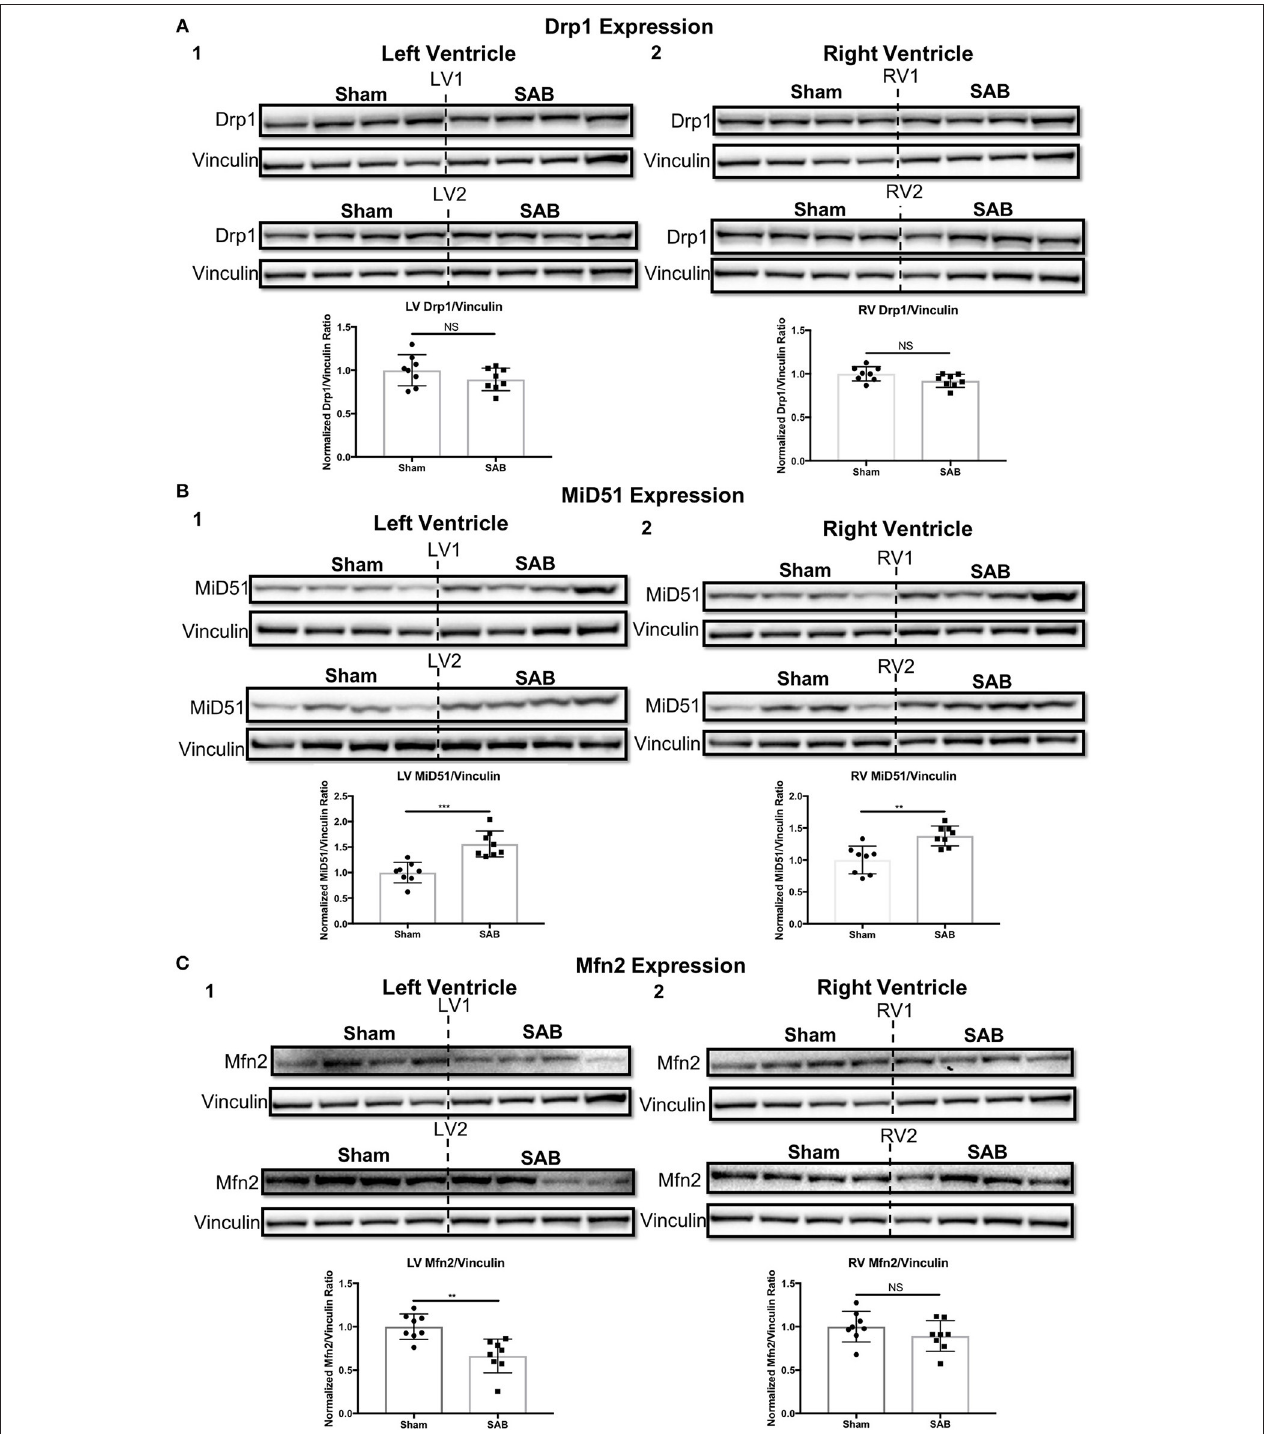
FIGURE 6 | Expression levels of mitochondrial fission/fusion mediators in sham vs. supra-coronary aortic banding (SAB) rats. (A) Western blot showing no change in the expression level of total dynamin-related protein 1 (Drp1) in the (1) left ventricle (LV) and (2) right ventricle (RV) of supra-coronary aortic banding (SAB) rats vs. sham rats. (B) Western blot showing significant upregulation of mitochondrial dynamics of 51 kDa protein (MiD51) in the (1) LV and (2) RV of supra-coronary aortic banding (SAB) rats vs. sham rats. (C) Western blot showing significant downregulation of mitofusin-2 (Mfn2) in the (1) LV and (2) RV of supra-coronary aortic banding (SAB) rats vs. sham rats. Each band represents a unique animal. Two experimental cohorts were done; hence two groups are shown, labeled as 1 and 2. The same vinculin loading control is used for proteins probed on the same membrane.